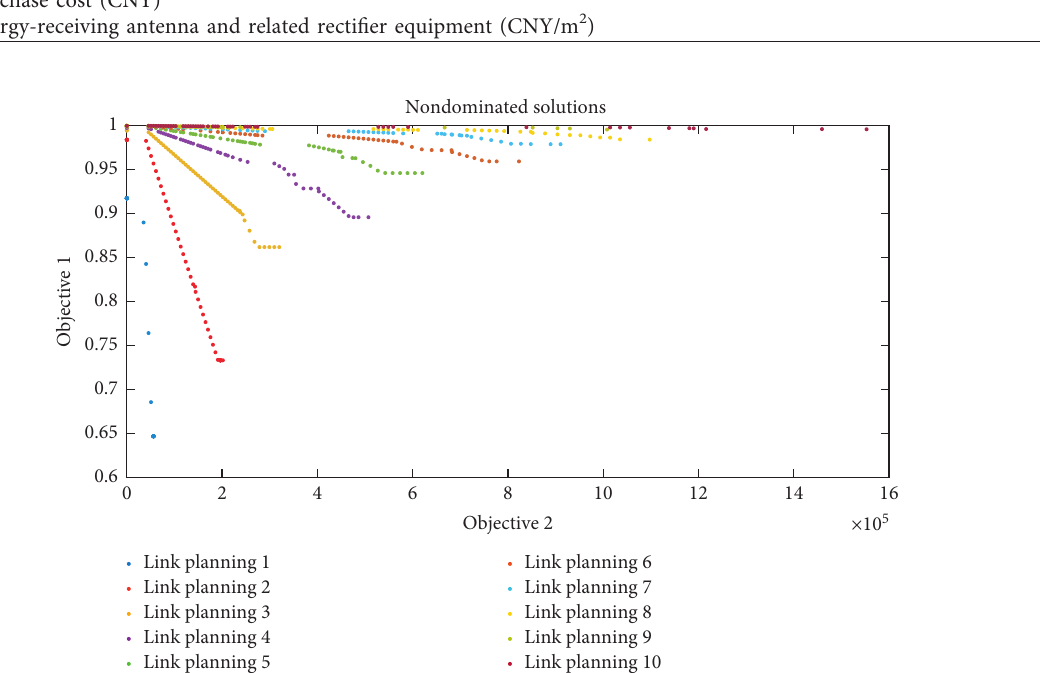
Figure 5: The optimal Pareto front obtained by solving 10 times.